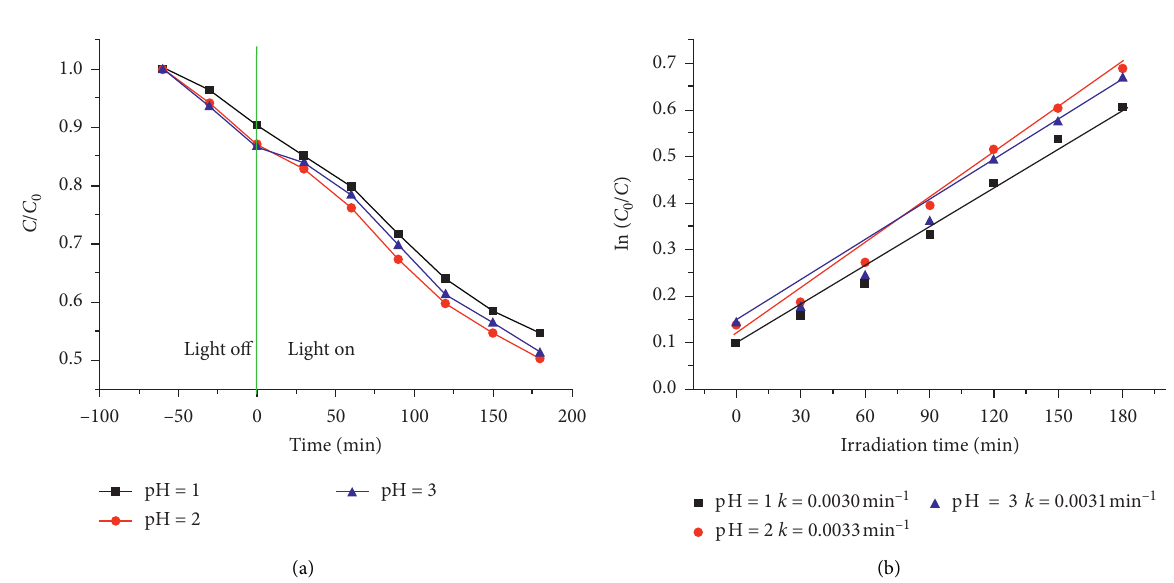
Figure 3: Effects of pH of reaction solution on the carbamazepine degradation